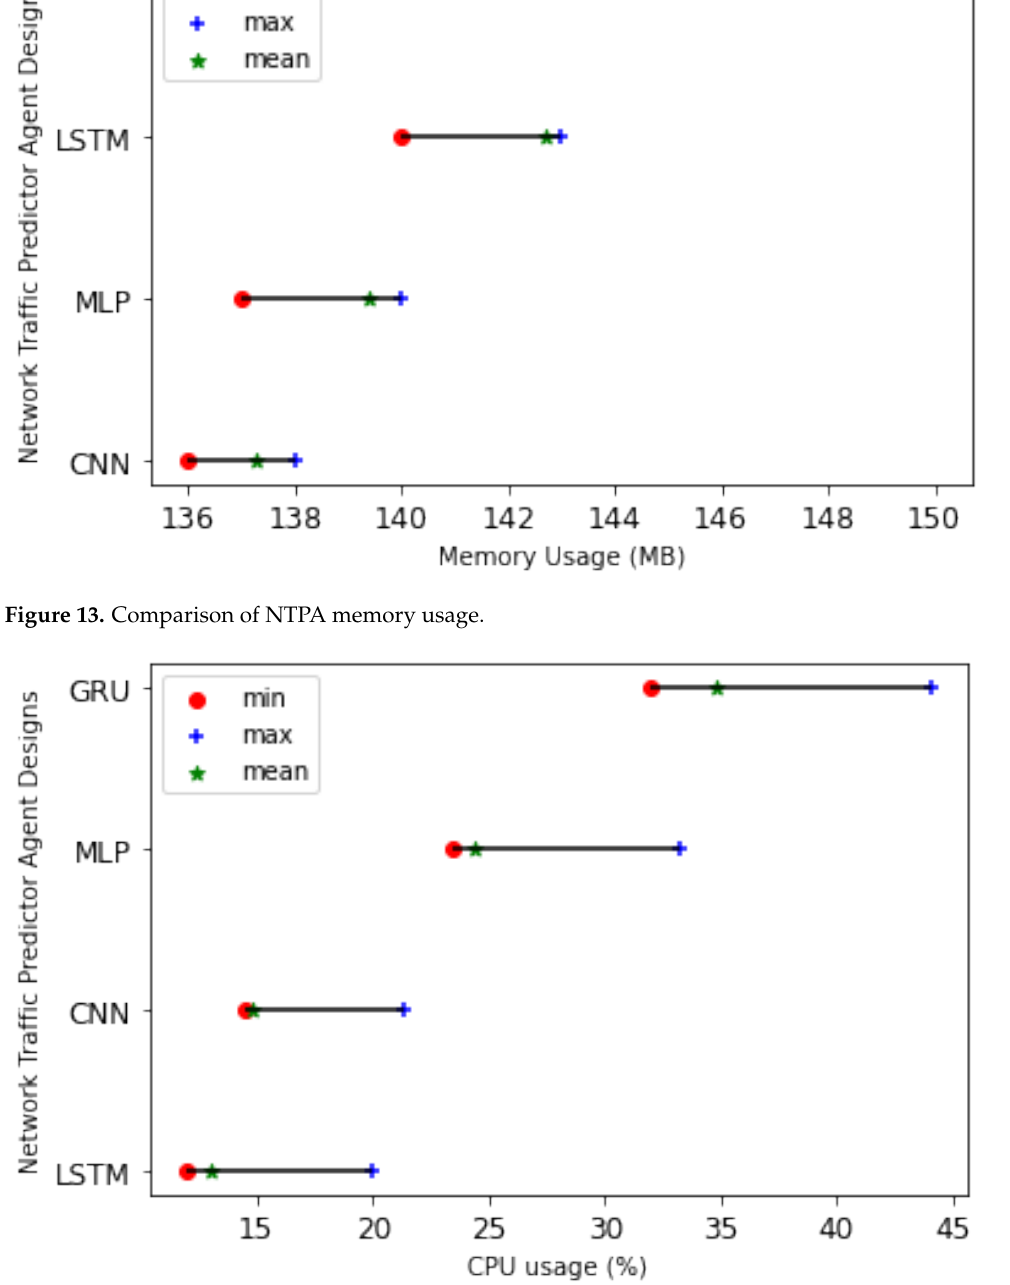
Figure 14. Comparison of NTPA CPU